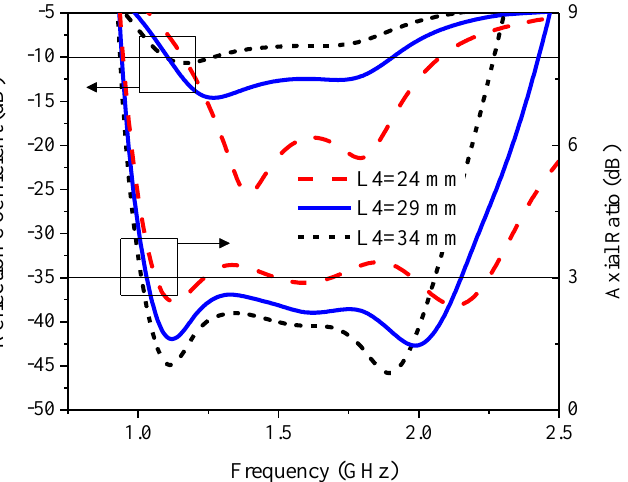
Figure 15. The simulated reflection coefficient and axial ratio under variable horizontal length ( L 4 ) of radiating patch.